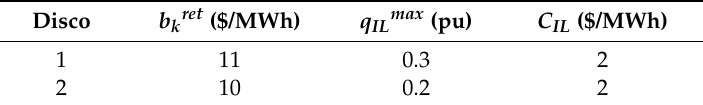
Table 3. Demand side information ( b kret , IL ).